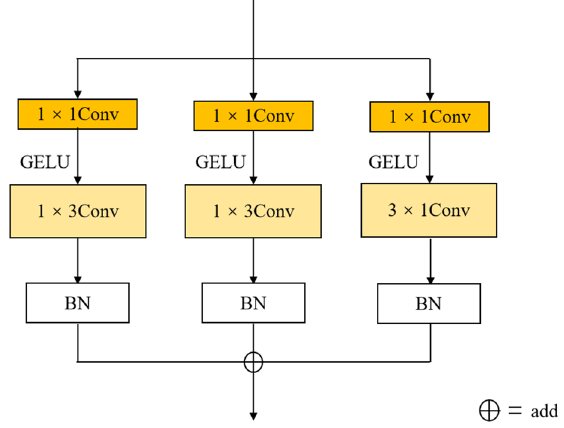
Figure 6. The structure of EAC Block.